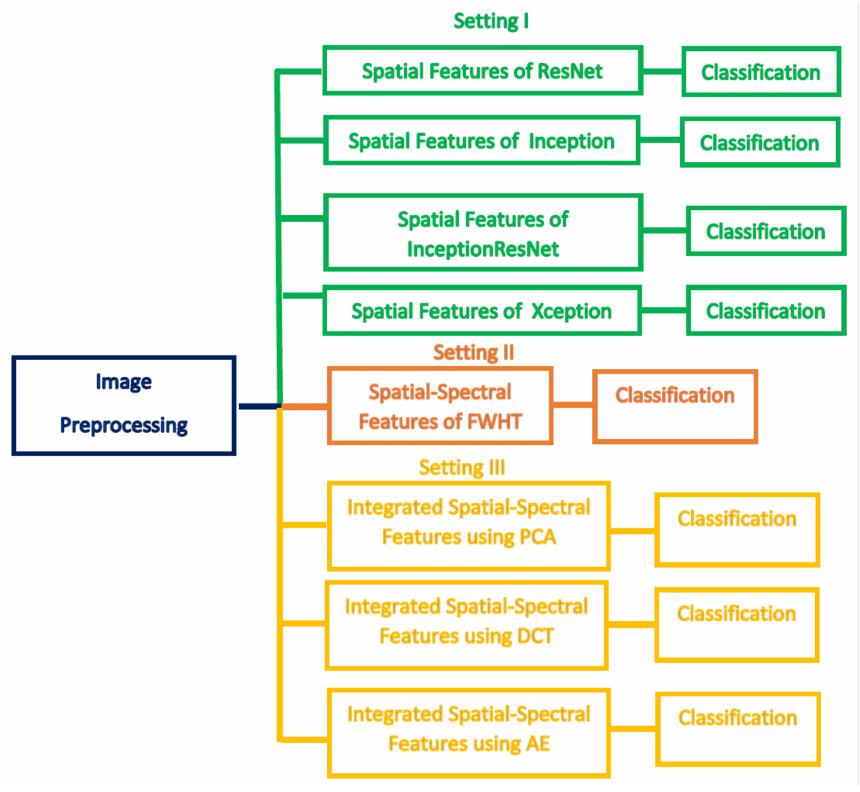
Figure 3. The three classification settings of DIAROP diagnostic tool. Table 1. The accuracy (%) attained using spatial features extracted from the four CNNs of DIAROP diagnostic